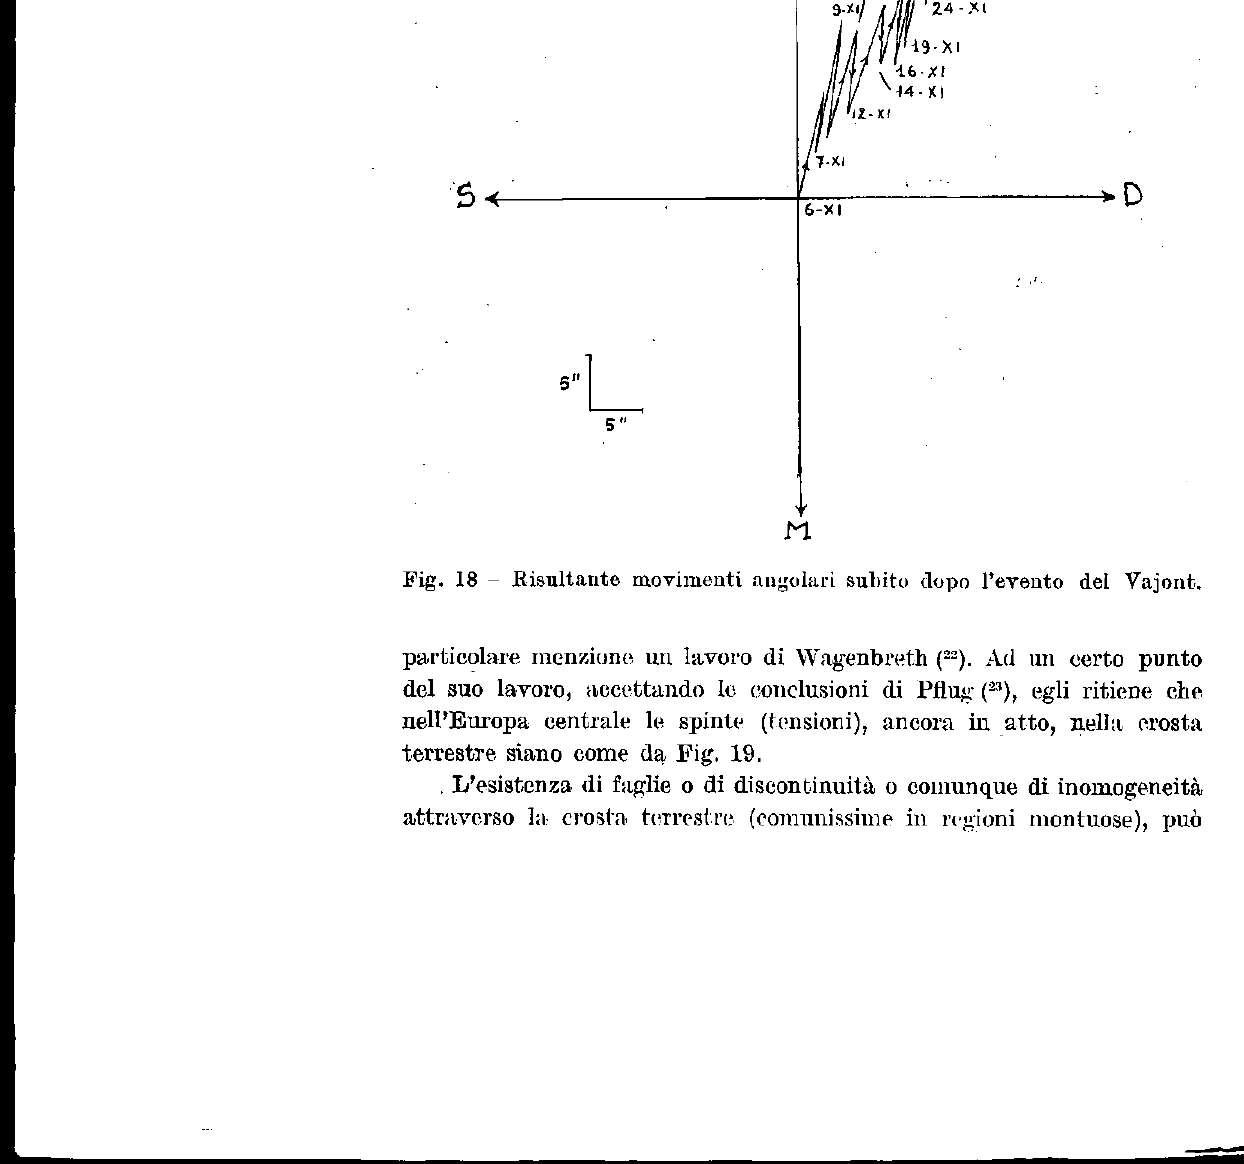
Fig. 18 - Risultante movimenti angolari subito dopo l'evento del Vajont.